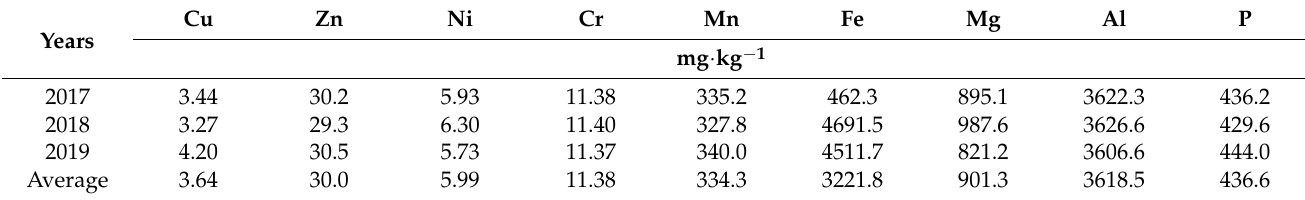
Table 4. Total elemental content determined in aqua